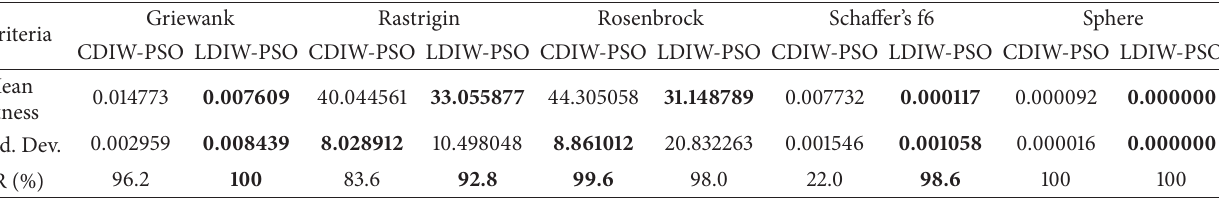
Table 4: Experimental results for LDIW-PSO compared with CDIW-PSO.